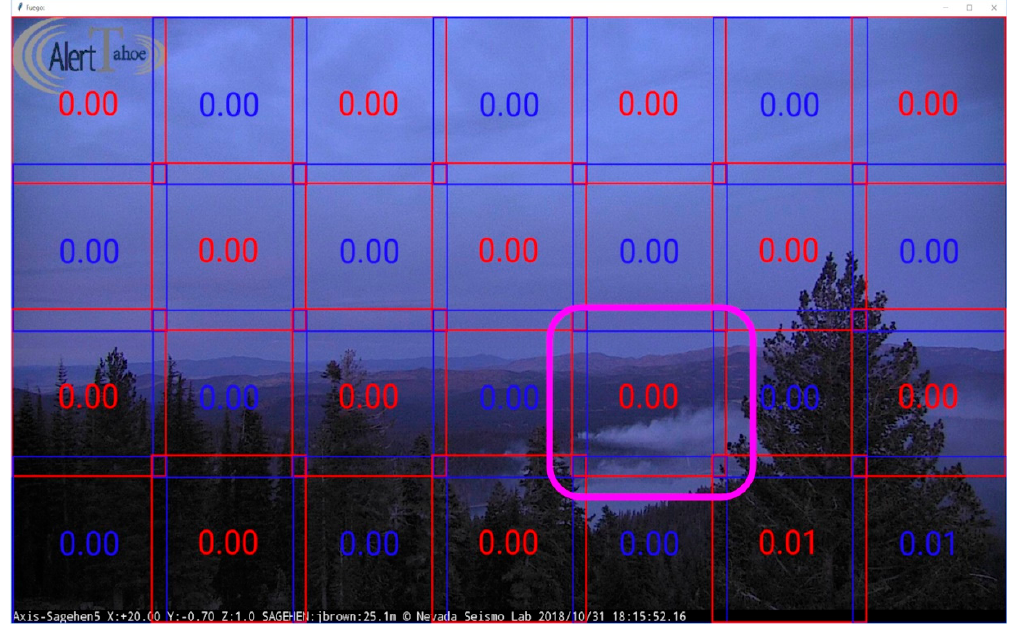
Figure 5. False negative, where smoke in highlighted segment is not detected. Our hypothesis is that this event resembles fog.